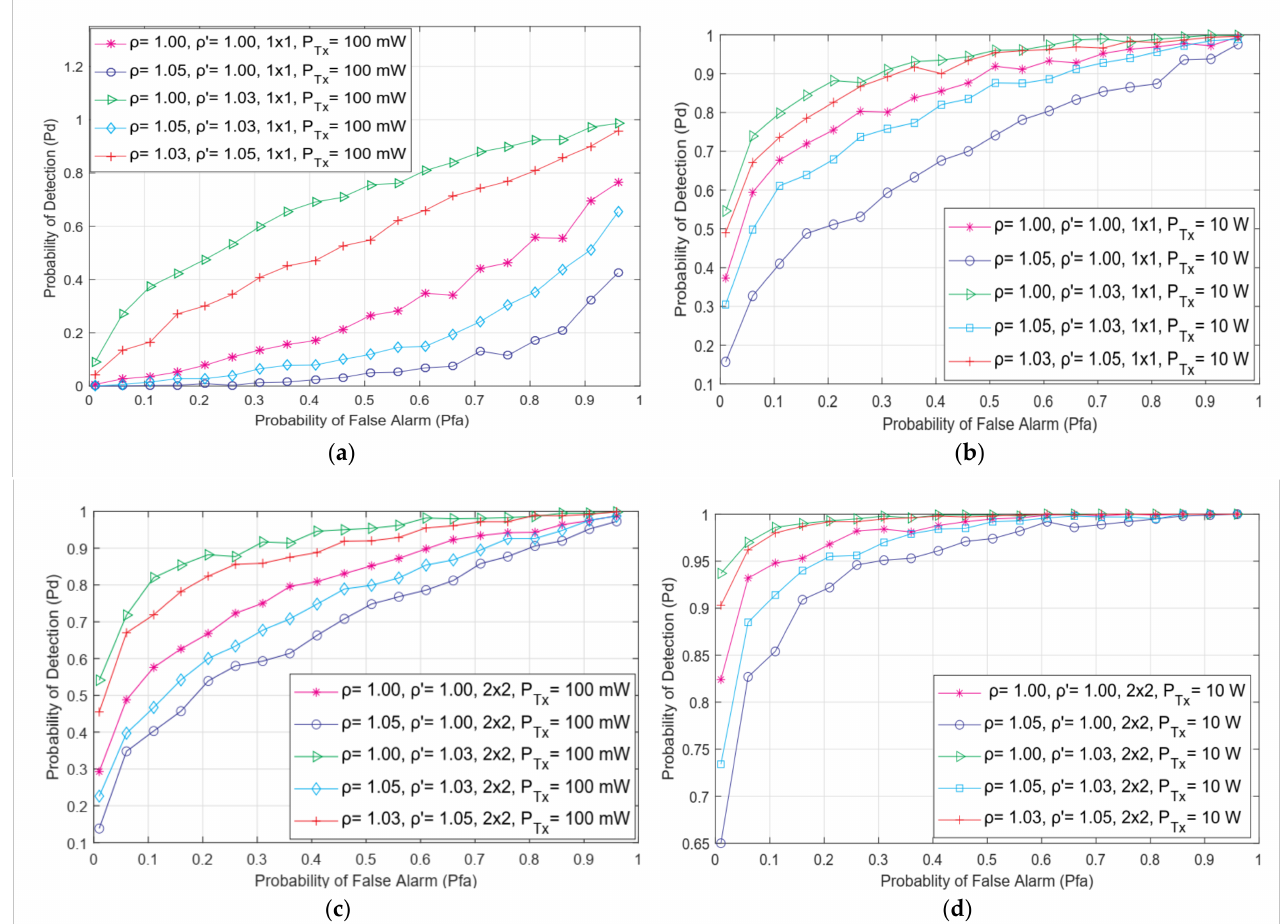
Figure 6. The ROC curves for various levels of NU and DDT factors in ( a ) SISO systems with the PU transmitting at 100 mW, ( b ) SISO systems with the PU transmitting at 10 W, ( c ) 2 × 2 MIMO systems with the PU transmitting at 100 mW, and ( d ) 2 × 2 MIMO system with the PU transmitting at 10 W and for transmission characterized with QPSK modulation, N = 128 and SNR = − 15